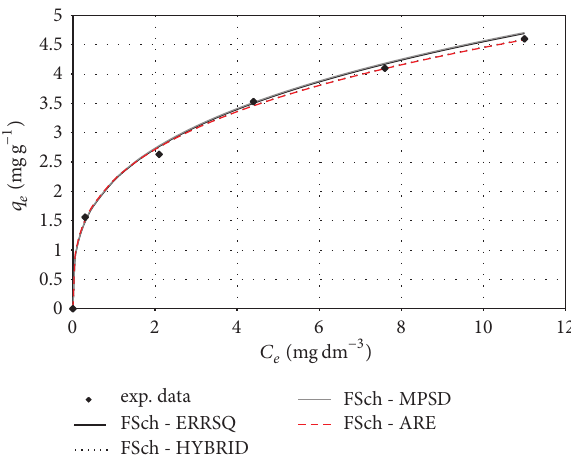
F 4: Experimental equilibrium data and multilayer iso- therms of p -NP biosorption on R. oryzae dead biomass